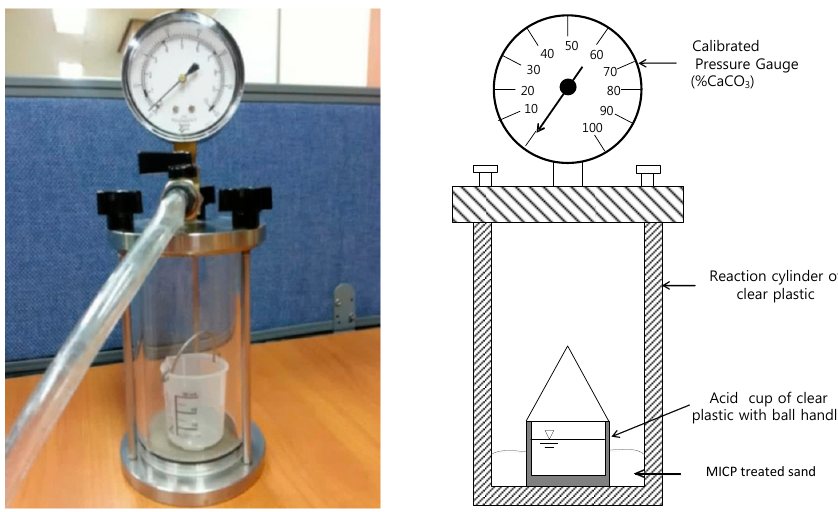
Figure 3. Calcium carbonate content chamber.